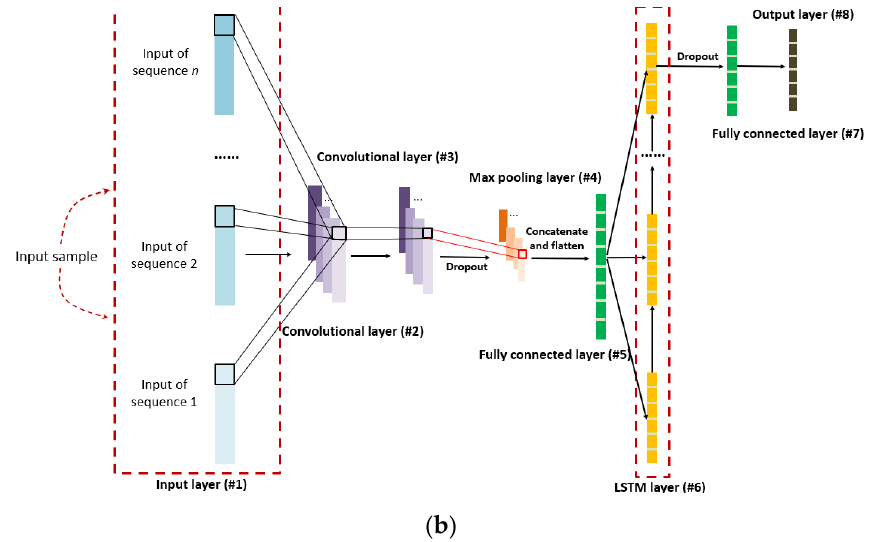
Figure 6. Architecture of CLSTM neural network model ( a ) fold; ( b ) unfold. Table 2. Layer configuration of CLSTM neural network model.